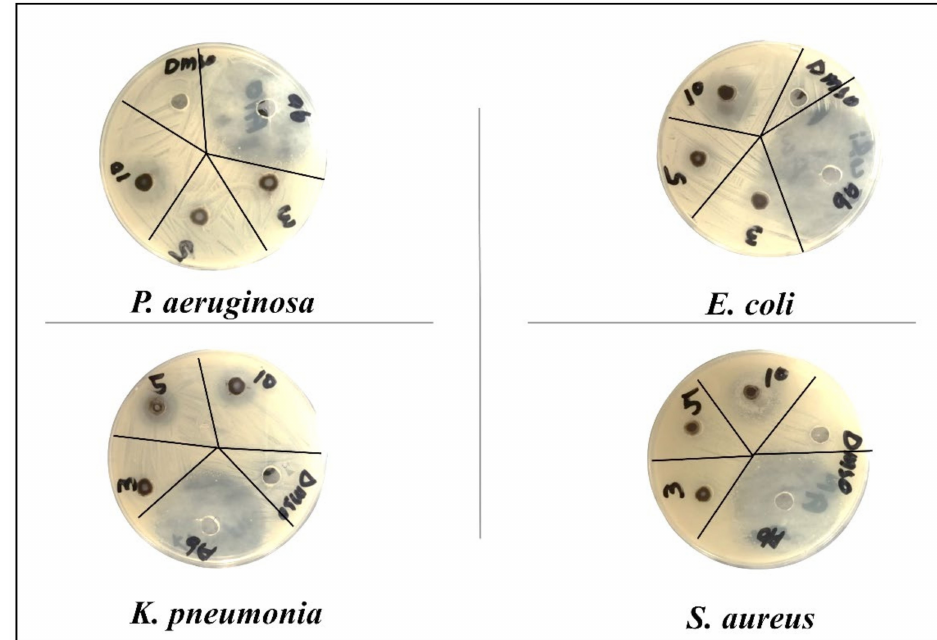
Figure 8. Zone of inhibition formed by CuO-NSs against different bacteria.